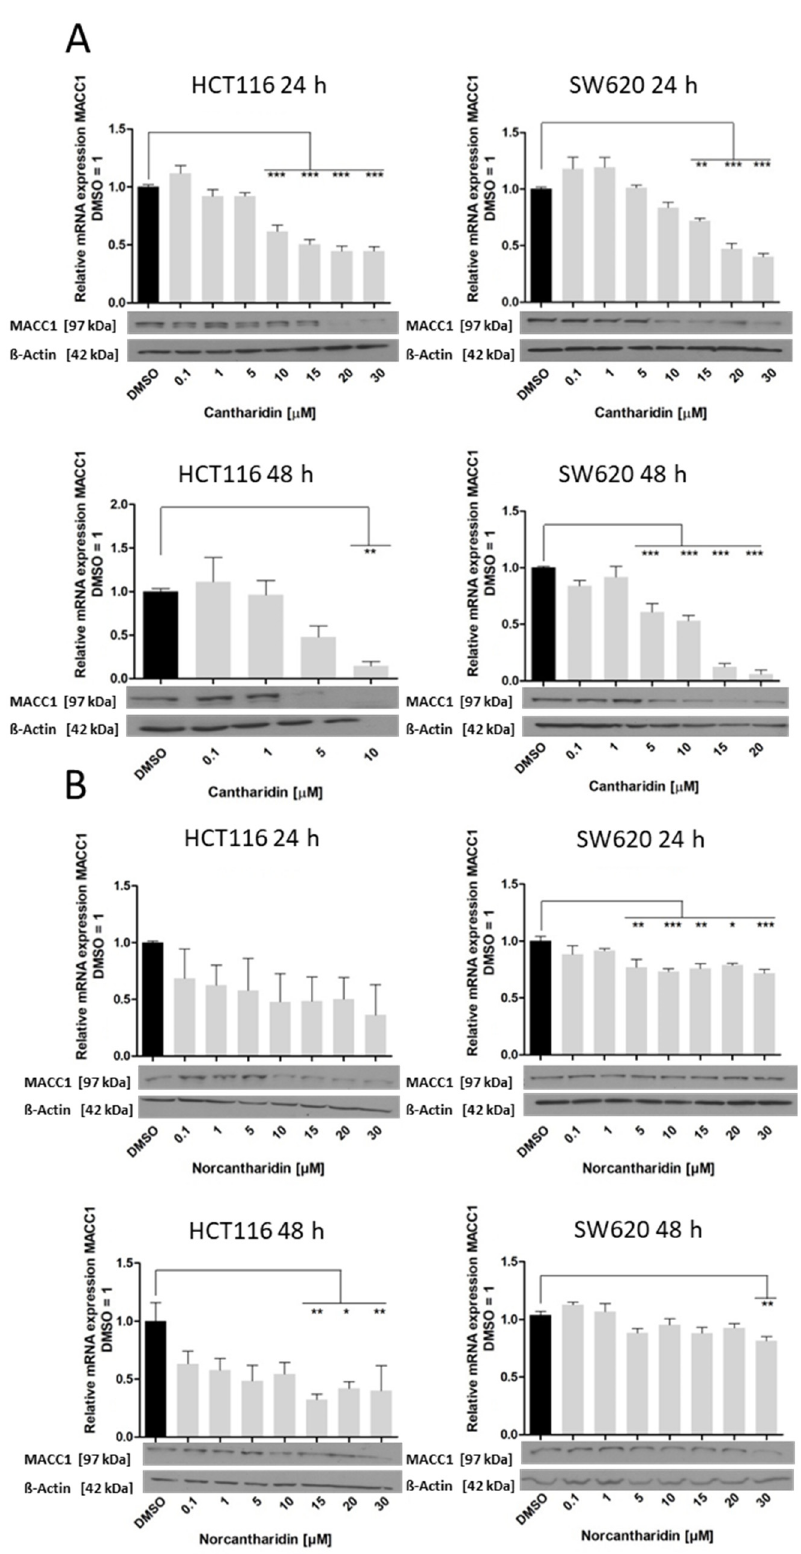
Figure 3. Effect of cantharidin and norcantharidin on MACC1 mRNA and protein expression after 24 h and 48 h. HCT116 and SW620 cells were treated daily with increasing concentrations (0.1–30 µM) vs. the DMSO control. RNA was extracted and RT-qPCR was conducted for the MACC1 mRNA represented as a percentage of the DMSO control of three independent experiments. The black bar indicates the DMSO control and the grey bars are the experimental samples which represent